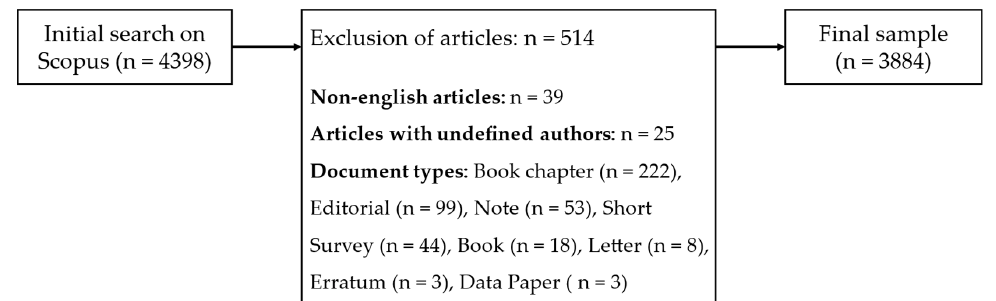
Figure 6. Overview of the data collection and the exclusion of articles.